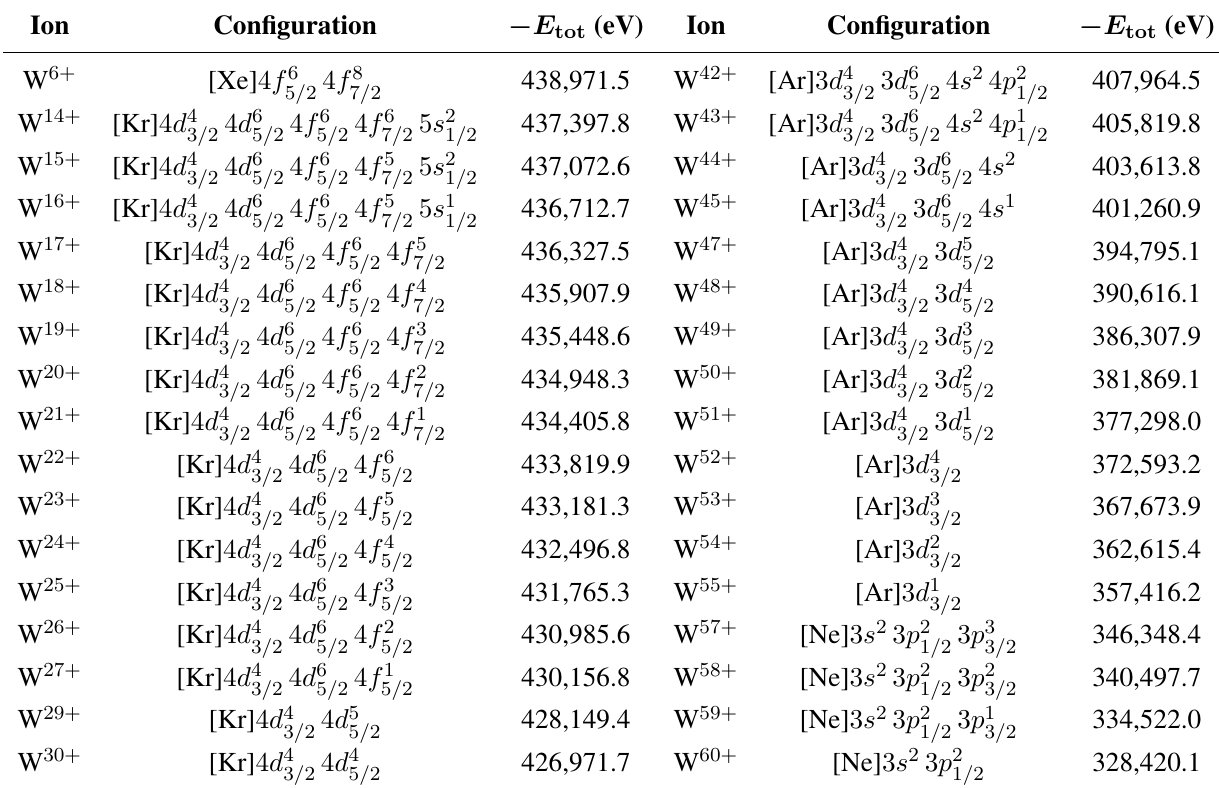
Figure 2. Partial RR cross-sections (RRCS) for RR of W 6+ with an electron captured in the 5 d , 5 f and 6 p states. Red, Dirac–Fock (DF) calculation with regard to the exact 3 / 2 5 / 2 1 / 2 electron exchange; blue, Dirac–Slater (DS) calculation with approximate consideration for the exchange. Electron configurations adopted for tungsten ions along with total energies calculated by the DF method taking into account the Breit magnetic interaction between